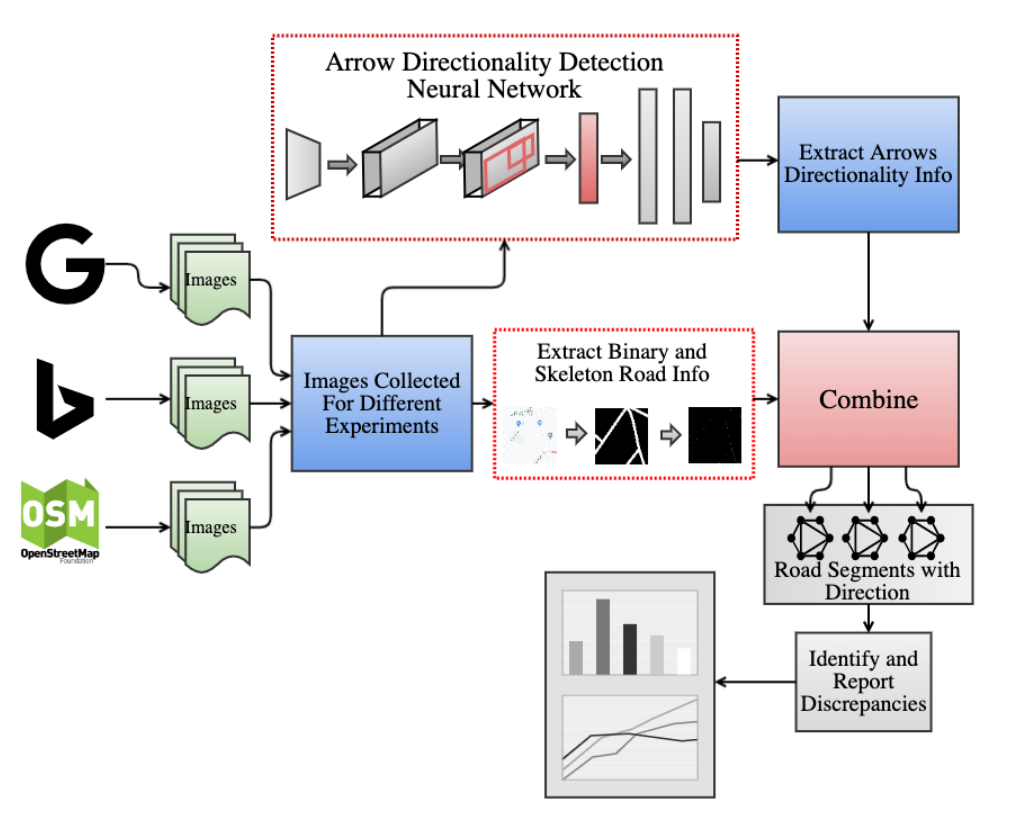
Figure 3. Overall system